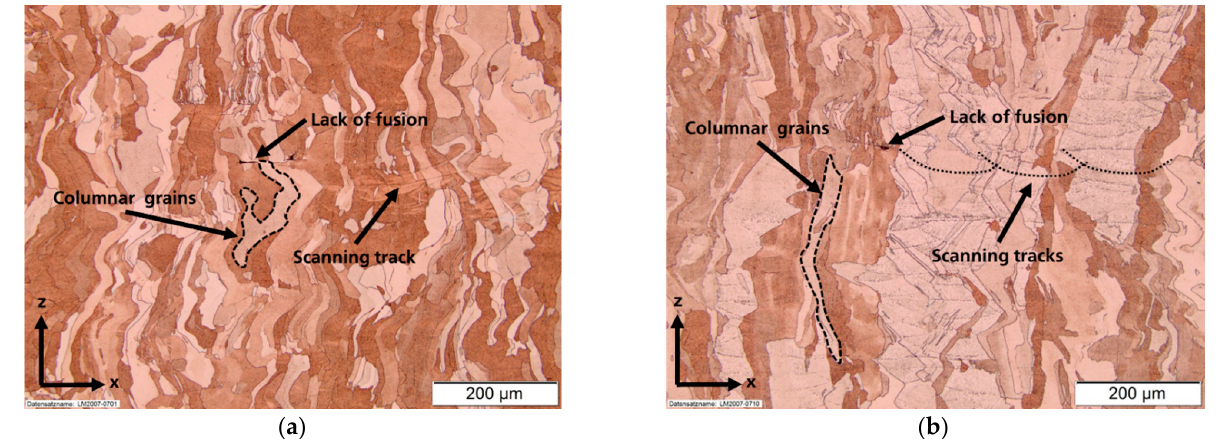
Figure 7. Microstructure of ( a ) Cu-OFHC in the x–z plane and ( b ) Cu-ETP in the x–z plane.